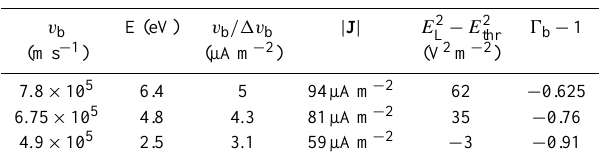
Table 4. Summary of electron beam bulk velocities used in